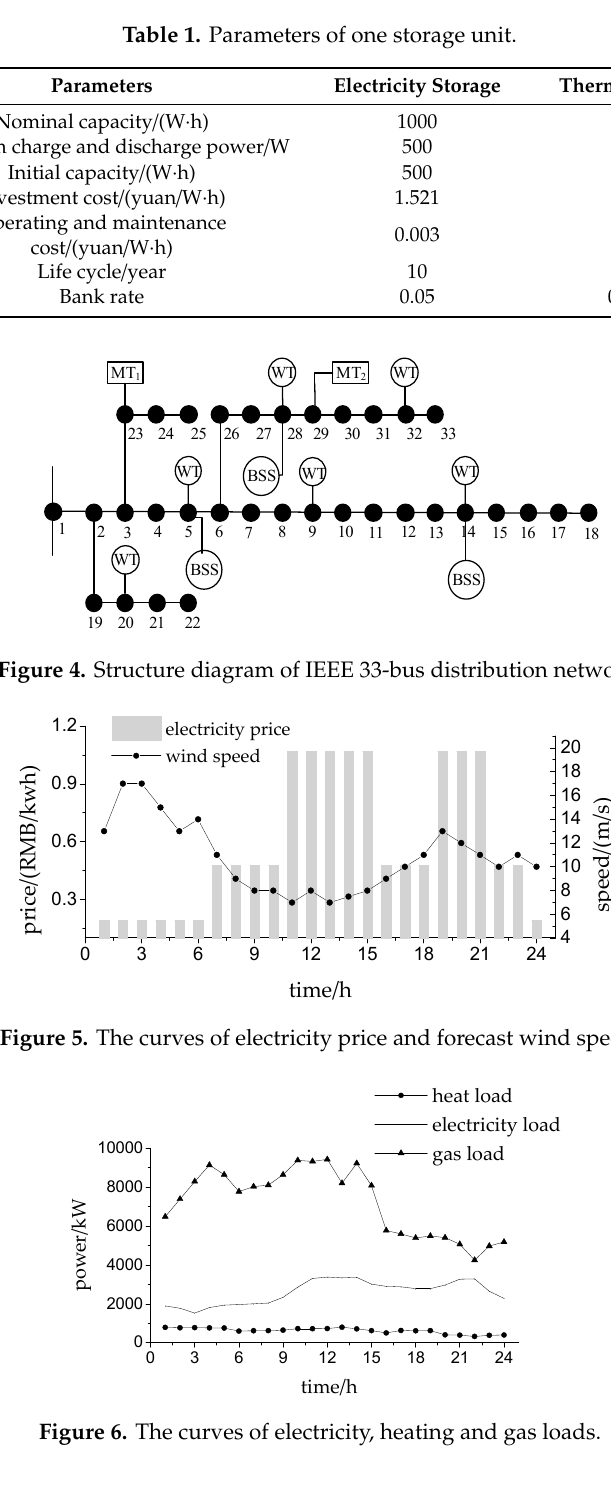
Table 1. Parameters of one storage unit.